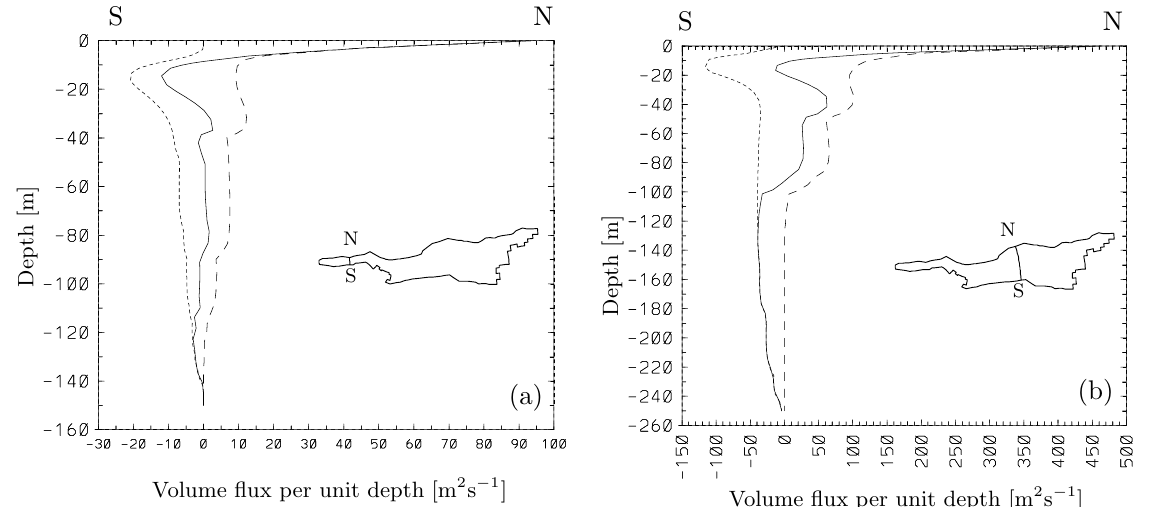
FIG. 21: Horizontally integrated volume flux per unit depth through the cross-sections in the ¨Uberlinger See (a) and in the Obersee (b) as indicated in the insets, computed with the vertical eddy viscosity ν v = 0 . 005 m 2 s − 1 . Broken curves indicate the transport part with the wind, dotted curves against the wind direction. The solid lines show the net volume flux